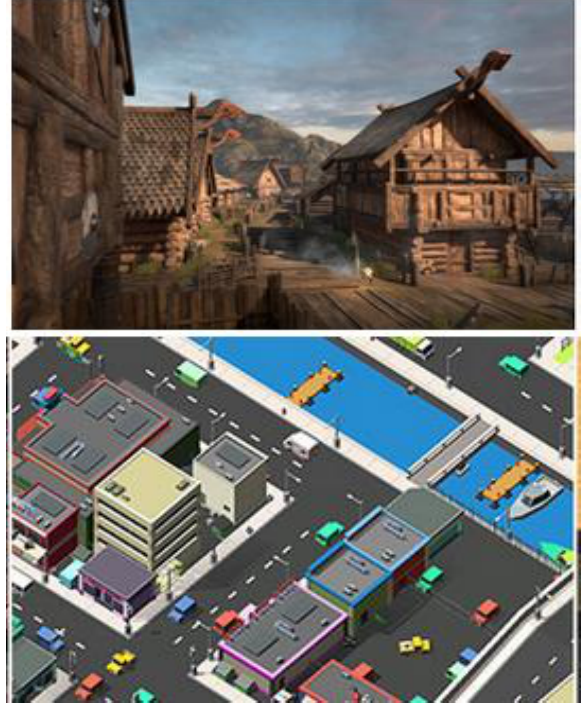
Figure 7. Examples of 3D scenes from the Unity’s sample projects (Unity,